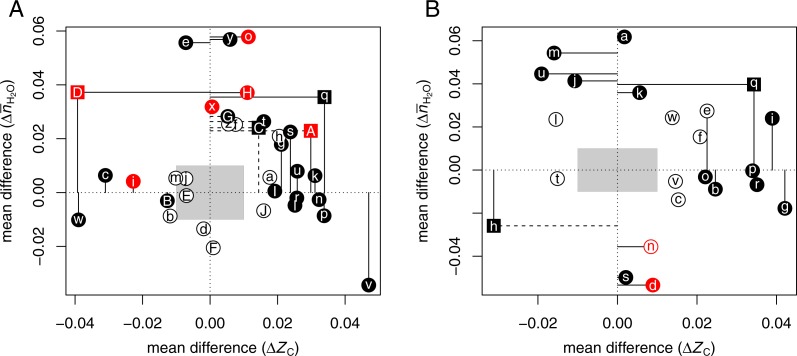
Compositional analysis of differential protein expression in (A) colorectal cancer and (B) pancreatic cancer.The plots show differences (Δ) between the mean for up-expressed and the mean for down-expressed proteins of average oxidation state of carbon (ZC) and water demand per residue (\documentclass[12pt]{minimal}
\usepackage{amsmath}
\usepackage{wasysym}
\usepackage{amsfonts}
\usepackage{amssymb}
\usepackage{amsbsy}
\usepackage{upgreek}
\usepackage{mathrsfs}
\setlength{\oddsidemargin}{-69pt}
\begin{document}
}{}${\bar {n}}_{{\mathrm{H}}_{2}\mathrm{O}}$\end{document}n ¯H2O) for each dataset from Tables 1 and 2. Red colors highlight (A) adenoma/normal comparisons or (B) chronic pancreatitis/normal or low-grade tumor/normal comparisons. Here and in Fig. 2, filled points and dashed lines indicate p < 0.05; solid lines are drawn instead if the common language effect size is ≥60% or ≤40%.